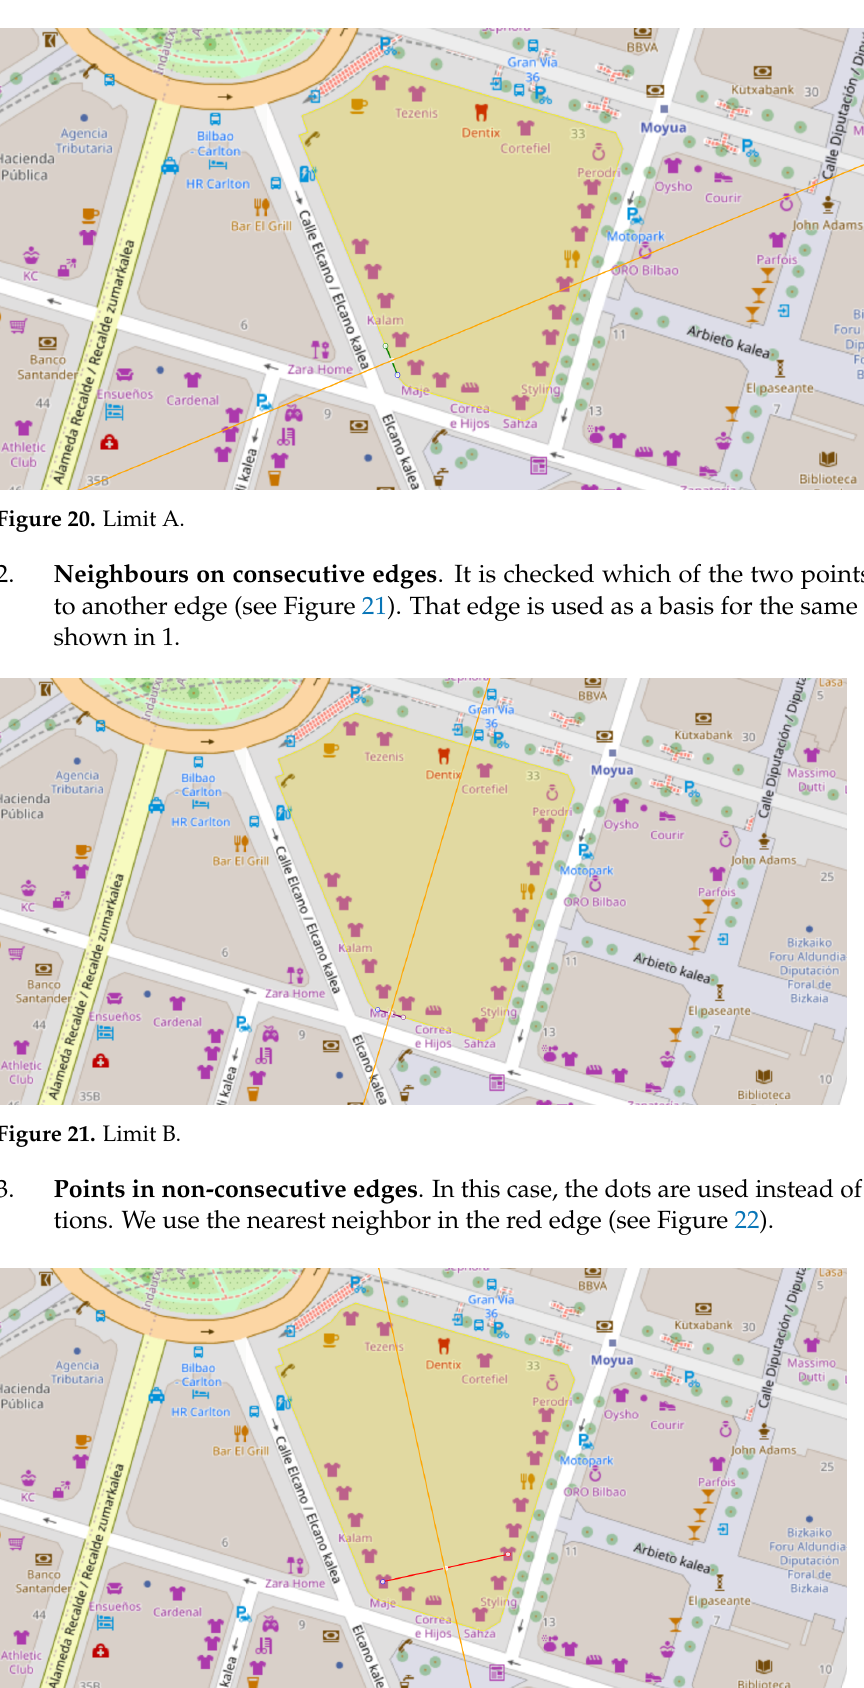
Figure 22. Limit